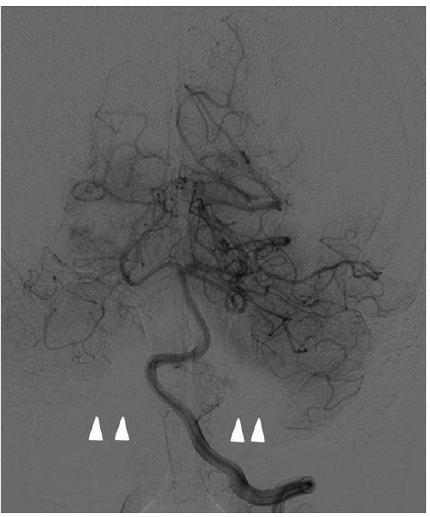
Figure 3: Left vertebral artery injection. There is no filling of the PICA and the corresponding territory.